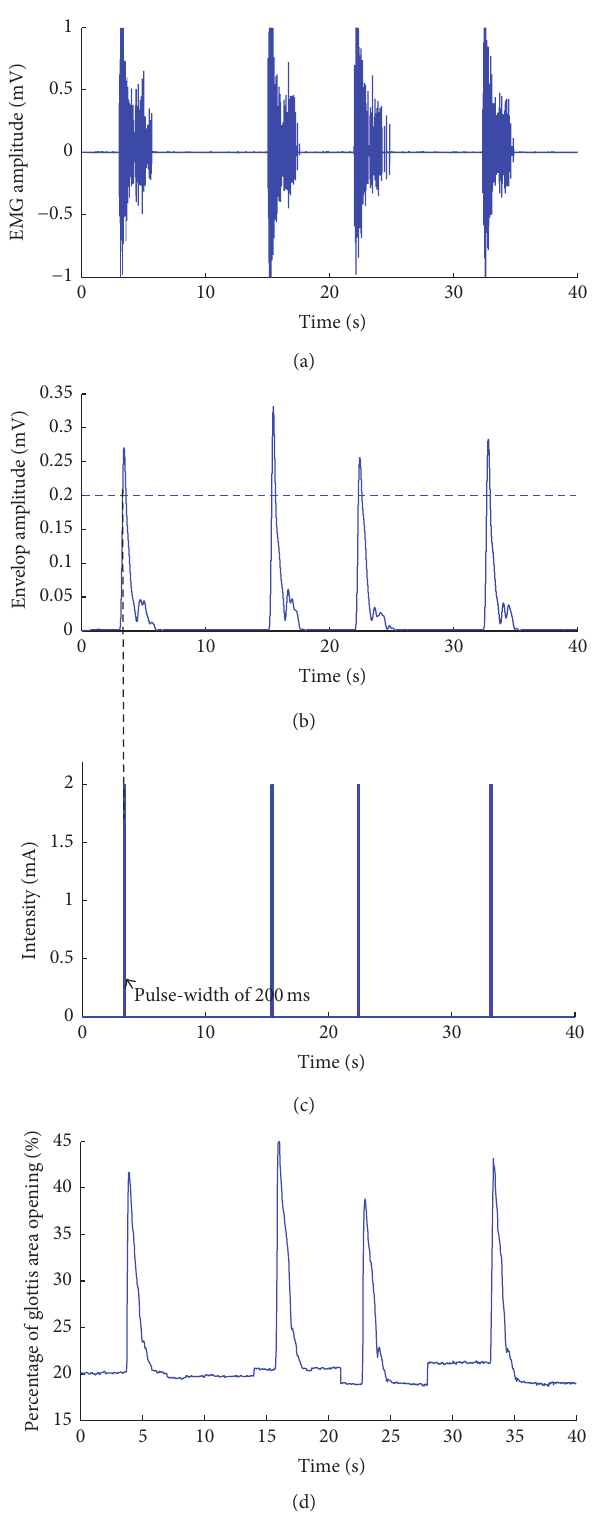
Figure 4: Procedure of extracting EMG signals envelope. (a) Plot of EMG amplitude changes over time. (b) Envelope of the EMG. (c) Triggered electrical stimulation, a pulse sequence with pulse-width of 200ms, and current amplitude of 2mA (period of 20 ms, duty- cycle varying from 50% to 100%). (d) Displacement of vocal fold across time in the intact